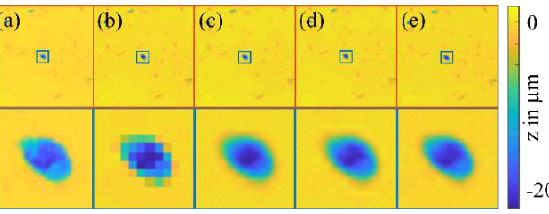
Fig. 2. Overview (top) and detailed view (bottom) of results for a 4x upscaling using different methods. Ground truth (a), nearest-neighbor (b), bilinear (c), bicubic (d) and VDSR (e).